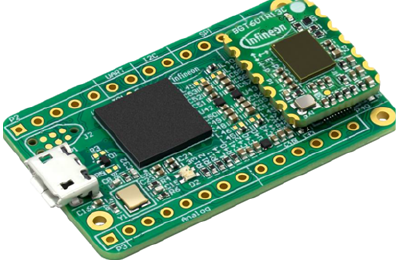
Figure 2. BGT60TR13C radar board [89].